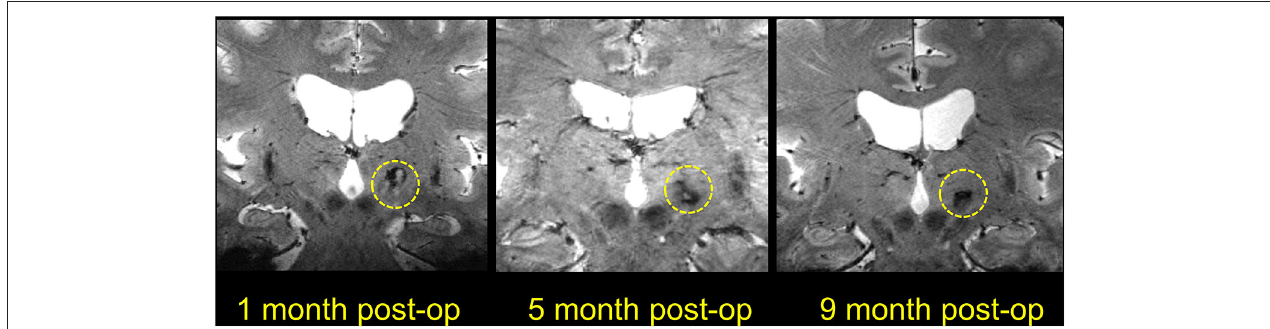
FIGURE 10 | Coronal T1-weighted 7T images showing lesions at different time points after MRgFUS thalamotomy. The three images are all from different patients, as the postoperative MR images were obtained at different time